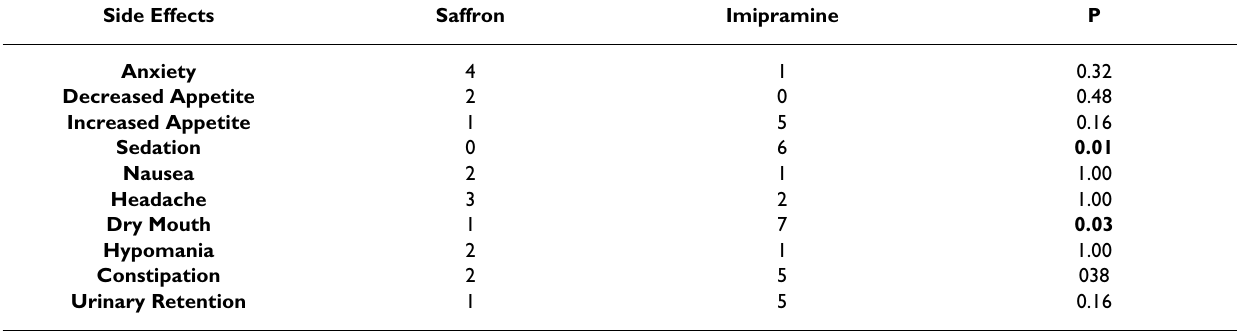
Table 2: Clinical complications and side effects were reported as number per